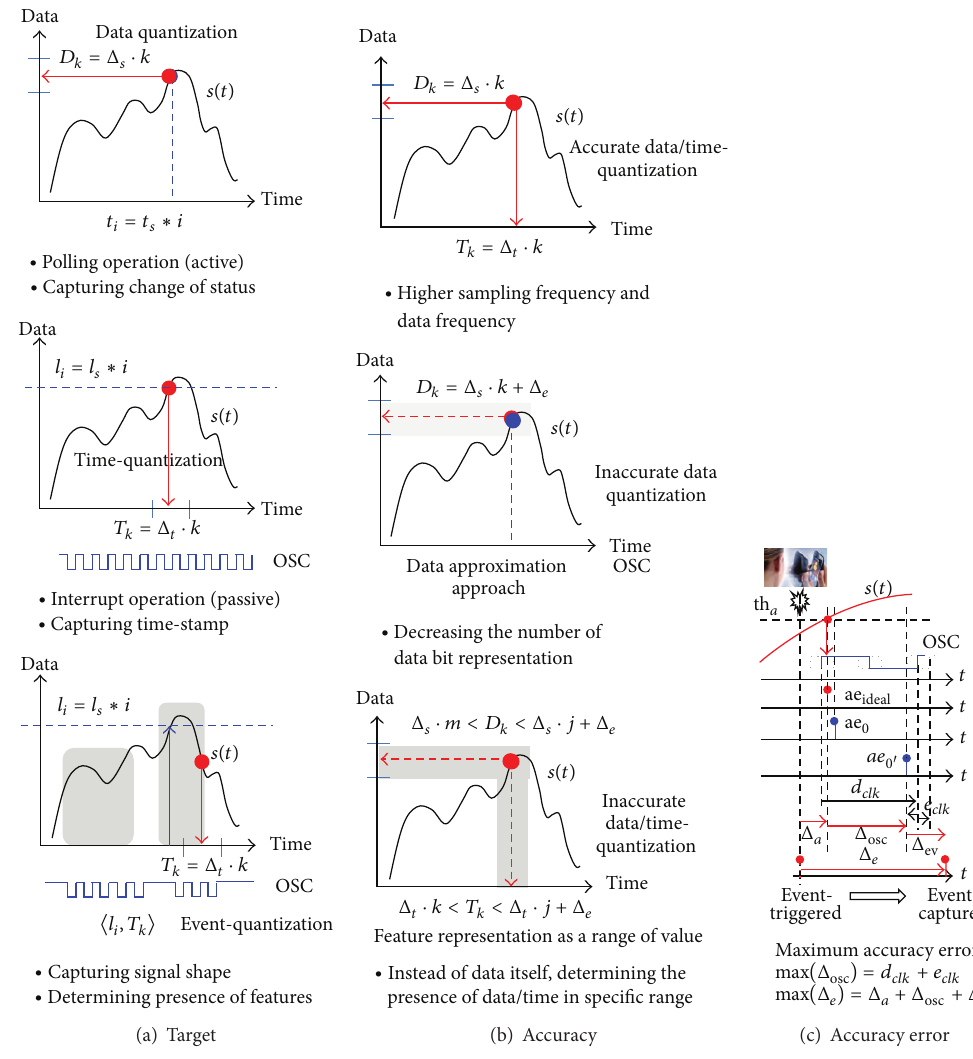
Figure 3: Category according to sampled target and its